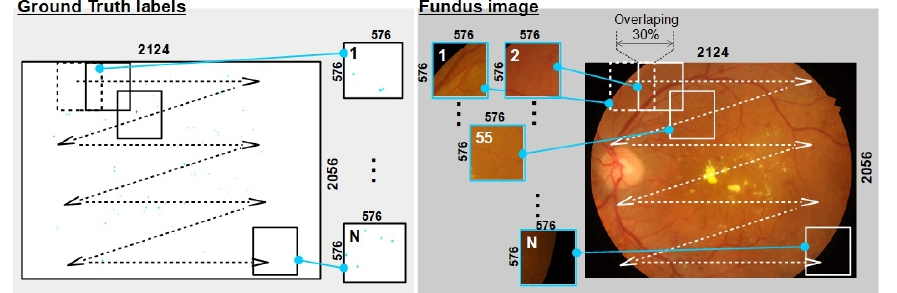
Figure 3. Functional selection diagram of the region of interest based on an overlapping sliding window approach.